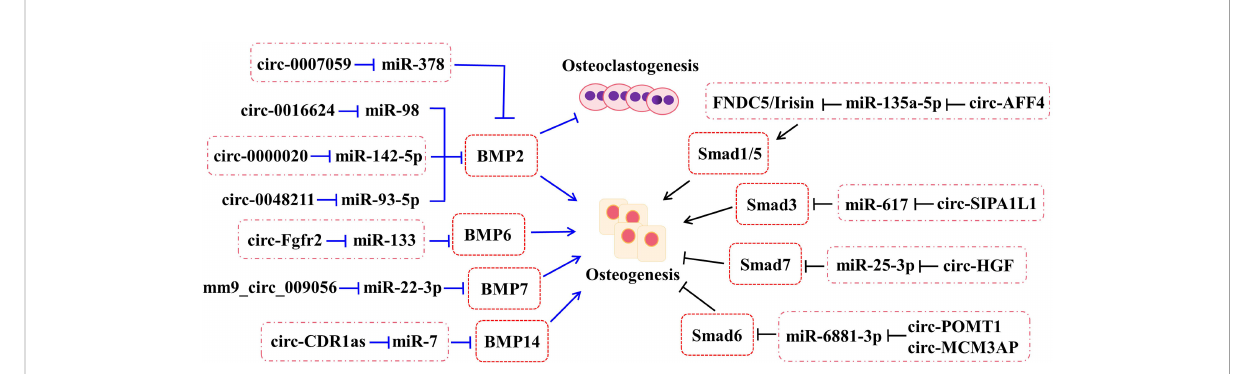
FIGURE 2 The roles of circRNA – miRNA – mRNA networks related to BMP and Smad pathways in bone development. The circRNA – miRNA – mRNA networks exert the potentials to regulate the bone development by BMP and Smad